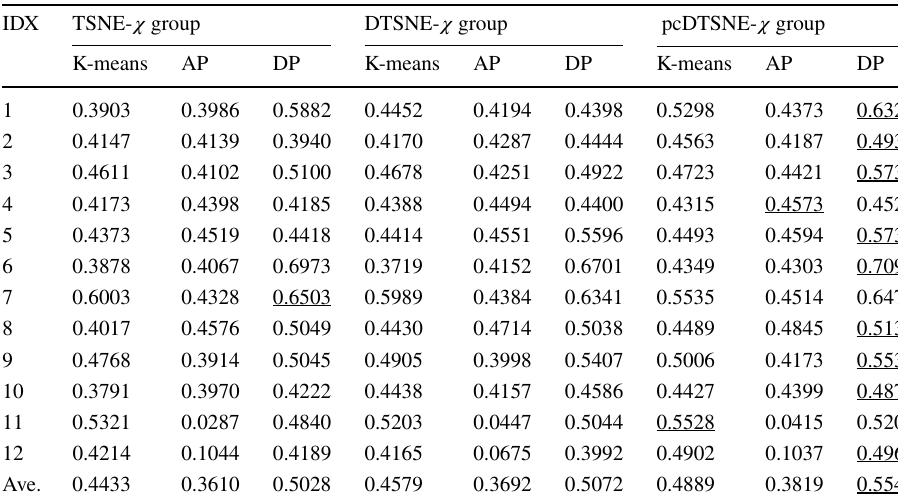
Table 3 Performance (purity) comparison of TSNE- 𝜒 group, DTSNE- 𝜒 group and pcDTSNE- 𝜒 group for clustering task over twelve datasets, and the highest score for each datasets among three type algorithms is denoted by underline